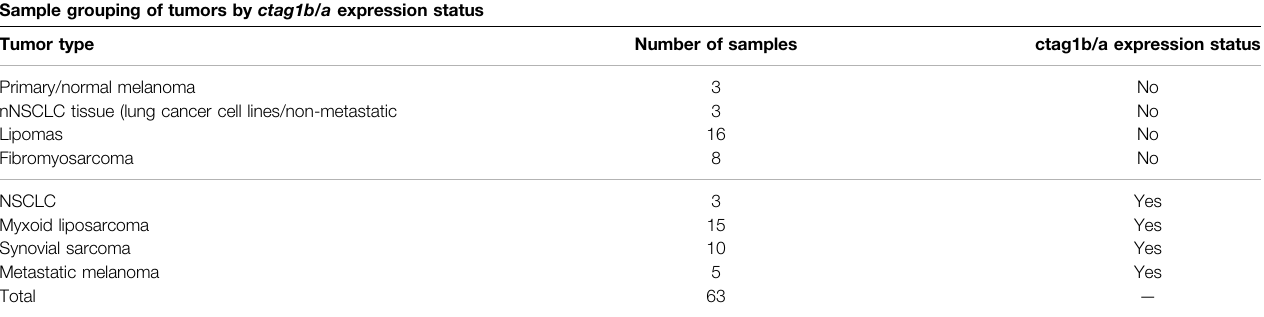
TABLE1| Differenttumortypesusedinextracting ctag1b/a modulesfromtrascriptomicsdata.Showninredaresamplesofadvancedsarcomatypesaswellasmelanomas that express ctag1b/a . Samples were grouped by tumor type and ctag1b/a expression status. Sample grouping of tumors by ctag1b/a expression status